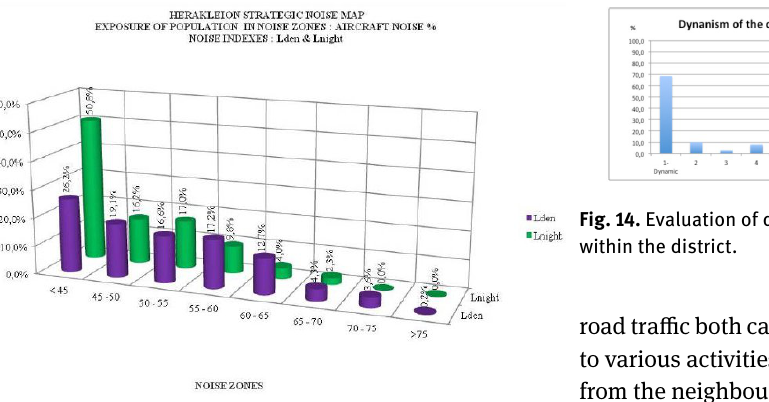
Fig. 10. Herakleion SNM 2012 – Population exposure to aircraft noise- Noise indices L den & L night .